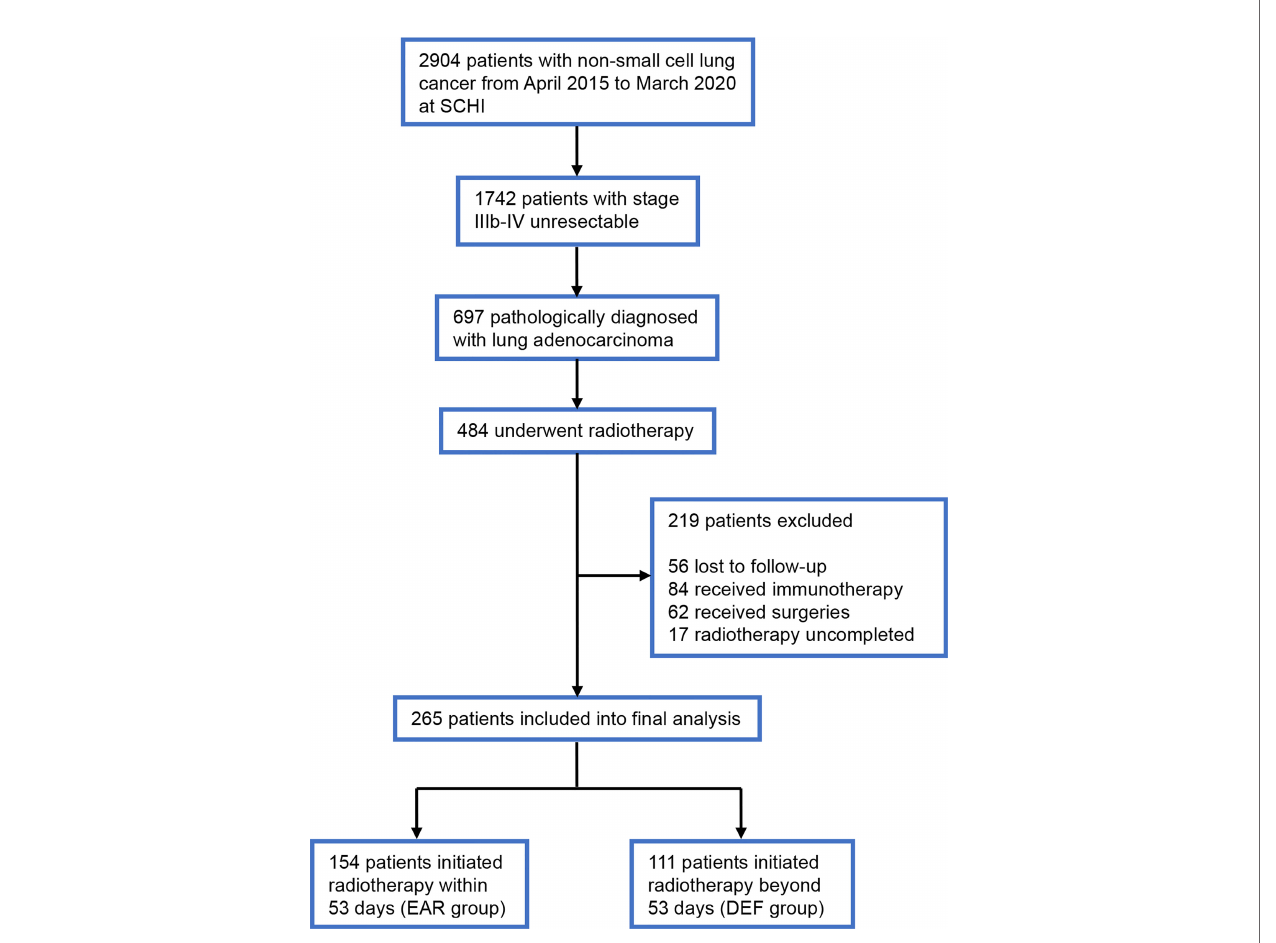
FIGURE 1 | Flowchart of the patient cohort. SCHI, Shandong Cancer Hospital and Institute; EAR, early to initiate radiotherapy group; DEF, deferred radiotherapy